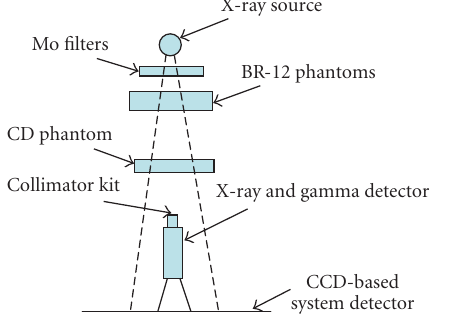
Figure 2: Schematic of contrast-detail phantom image acquisition system.